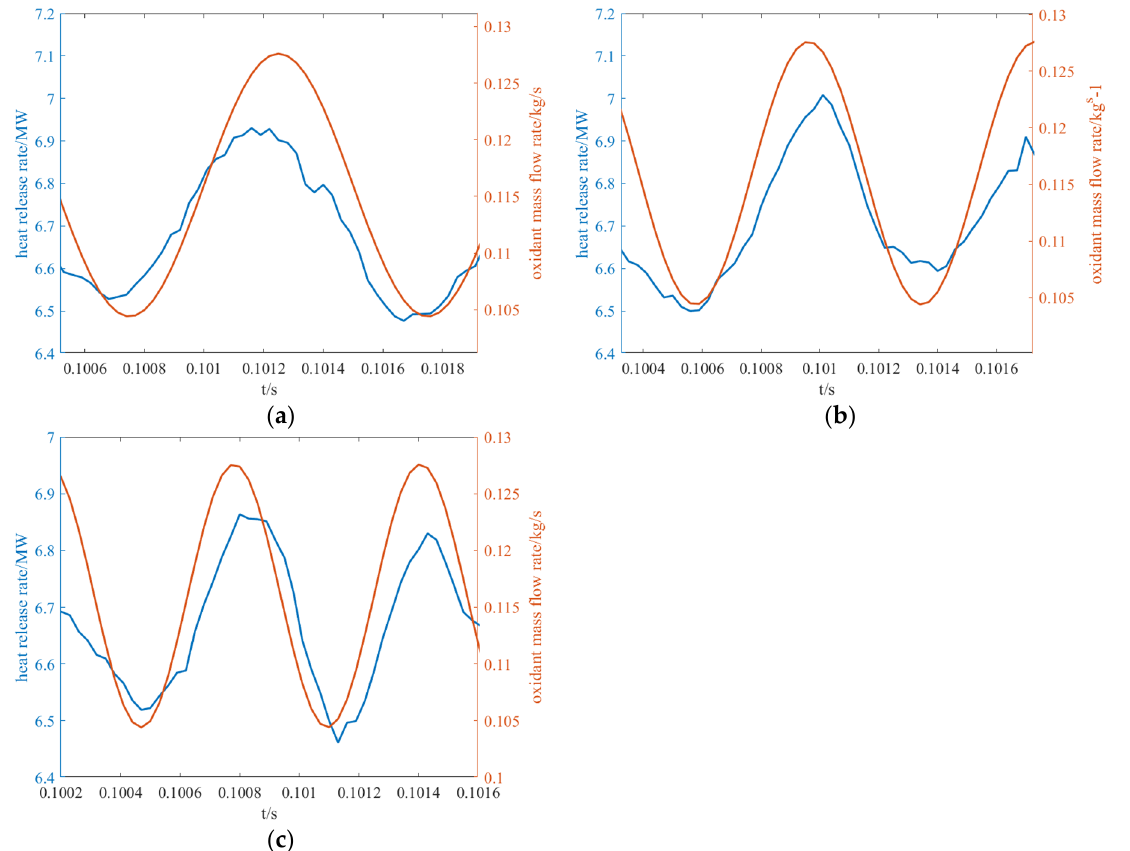
Figure 10. The relationship between the sum of heat release rate and inlet flow rate pulsation. ( a ) 1000 Hz. ( b ) 1300 Hz. ( c ) 1600 Hz. Table 7. Frequency and stability of the first-order longitudinal, zero-order tangential, zero-order radial modes for Schemes 1, 5, and6.